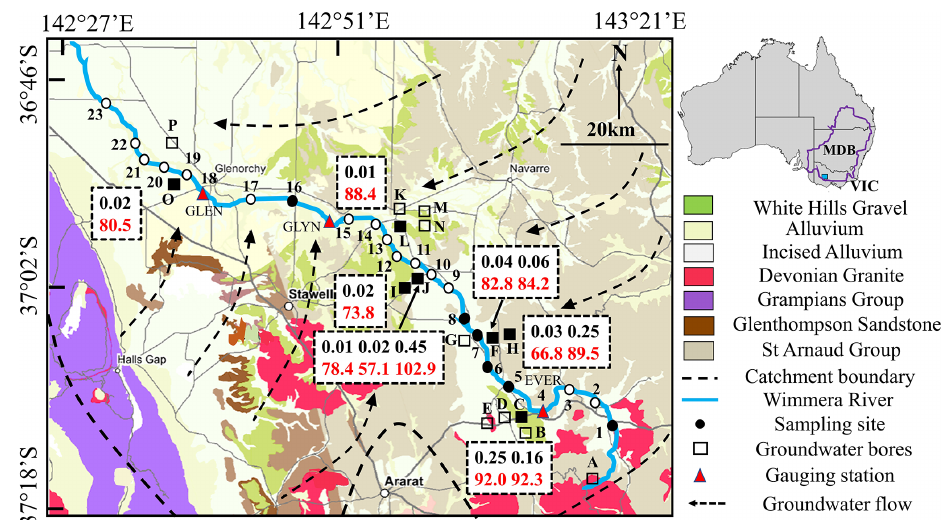
Figure 1. Summary geological and hydrogeological map of the upper Wimmera River. Stream water sampling sites and groundwater bores are indicated by numbers and letters, respectively. The sites that have radioactive isotope data are shown in solid symbols. Gauging stations with site number are Eversley (EVER; 415207), Glynwylln (GLYN; 415206), and Glenorchy (GLEN; 415201). Background geological map from Department of Jobs, Precincts and Regions (2021) (© State Government of Victoria 1996–2021); other information from Robinson et al. (2006), Department of Environment, Land, Water and Planning (2021), and Zhou and Cartwright (2021). Boxes show 14 C (red) and 3 H activities (black) of groundwater (data from Table